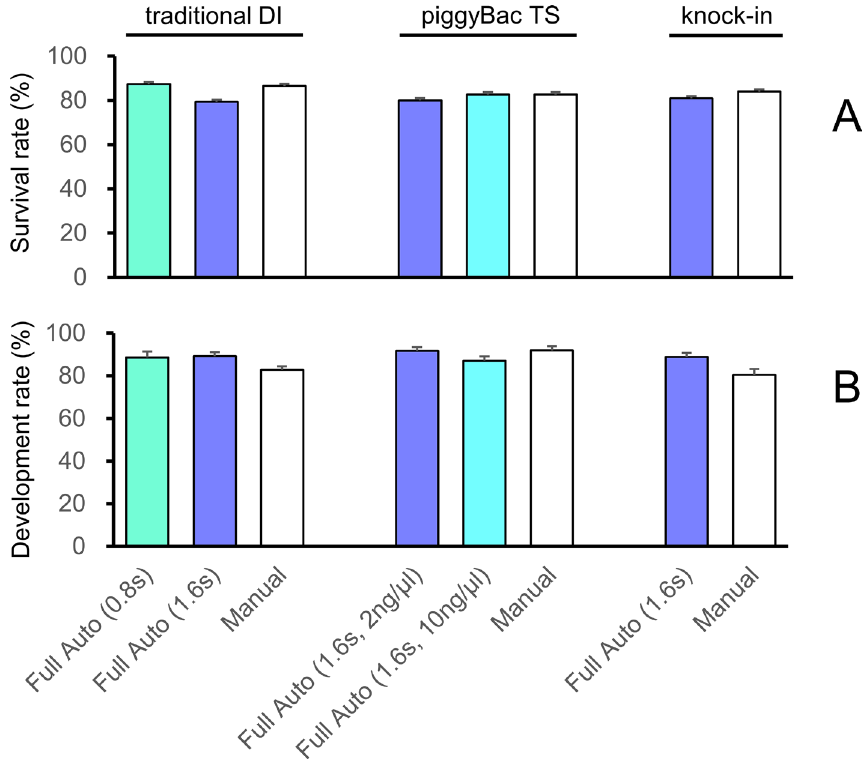
Figure 7. Survival and in vitro development of zygotes injected into the pronucleus with solutions used for 3 different genetic modifications. In the fully automated solution injection, all injection pressures were fixed at 30 hPa, and the injection time was 0.8 or 1.6 s for traditional DNA injection (traditional DI), and 1.6 s for the piggyBac Transposon system (piggyBac TS) and CRISPR-Cas9 system (knock-in). In addition, the piggyBac TS used solutions with a DNA concentration of 2 or 10 ng/µl. The survival rate ( A ) and development rate to a 2-cell stage embryo ( B ) after solution injection did not differ significantly among groups with fully automated and manual injections.